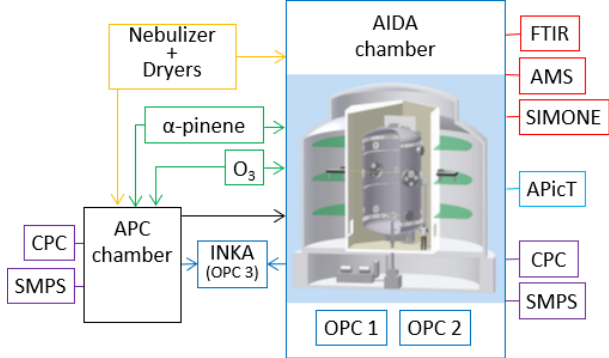
Figure 2. Schematic of the AIDA facility with experimental setup and instrumentation. Yellow outline: crystalline ammonium sul- fate particles were generated with a nebulizer and a series of dif- fusion dryers. Green outlines: secondary organic matter was gen- erated from the ozonolysis of α -pinene. Purple outlines: particle number concentration and number size distribution measurements performed with condensation particle counters (CPCs) and scan- ning mobility particle sizers (SMPSs). Light blue outline: water vapor concentration was measured with an in situ multi-path tun- able diode laser absorption spectrometer (APicT). Red outlines: the physico-chemical characterization of the aerosol particles was ob- tained from a Fourier transform infrared spectrometer (FTIR), a high-resolution time-of-flight aerosol mass spectrometer (HR-ToF- AMS), and by light-scattering and depolarization measurements (SIMONE instrument). Blue outlines: the ice nucleation ability of the investigated particles was measured with expansion cooling ex- periments in the AIDA chamber and with a continuous flow diffu- sion chamber (INKA). OPC: optical particle counter. More details are provided in the main